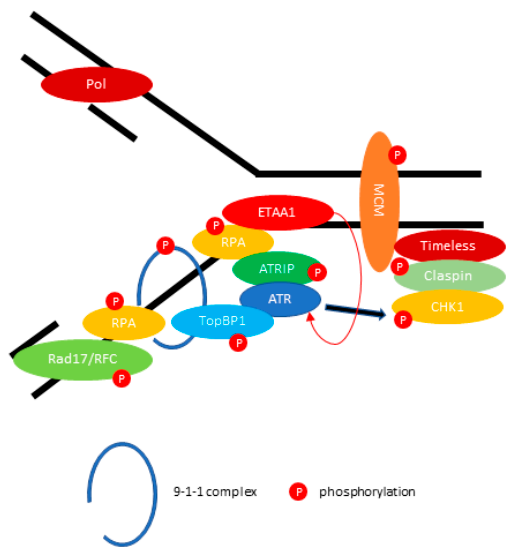
Figure 2. ATR (ATM and Rad3-related) mediates DNA repair during replication fork stalling. ATR kinase activity is stimulated by DNA topoisomerase 2-binding protein 1 (TopBP1) or Ewing tumor-associated antigen 1 (ETAA1). The activated ATR-ATRIP phosphorylates CHK1 through the Claspin/Timeless complex. The red arrow indicates the activation of ATR directly by ETAA1. The black arrow indicates the phosphorylation of Checkpoint kinase 1 (CHK1) through activated ATR.